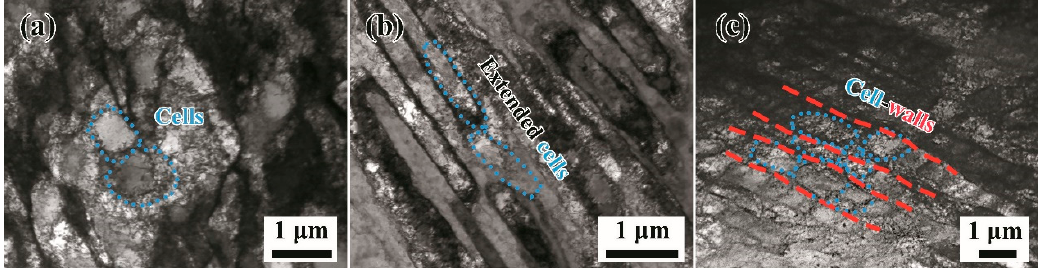
Figure 5. TEM images of different kinds of dislocation structures of Cu–Ni alloys uniaxially compressed up to a true strain of 30%. ( a ) Dislocation cells in the Cu–5at.% Ni alloy, ( b ) extended cells in the Cu–10at.% Ni alloy, and ( c ) oriented cell walls in the Cu–20at.% Ni alloy.